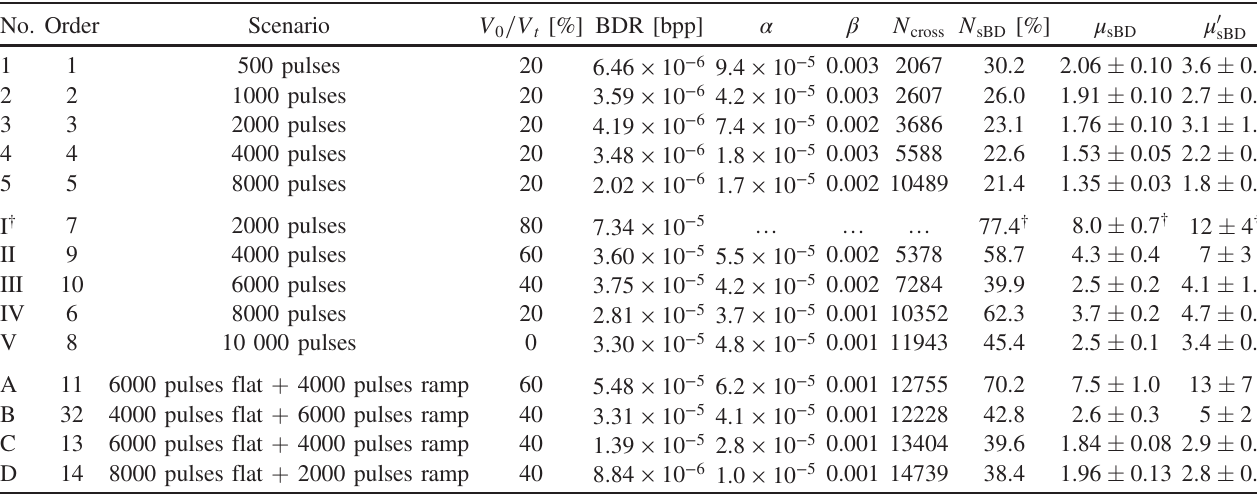
TABLE II. Key figures for the BD experiments with different ramping scenarios. The first column denotes the measurement id and the second one shows the order the measurements were performed in. Values of breakdown rate (BDR), two-exponential PDF fit parameters ( α and β ), cross-point of the two exponentials ( N ), percentage of sBDs ( N ), the average number of BDs between two pBDs cross sBD (including the previous pBD) ( μ ), and the fraction of the number of sBDs to pBDs for those series with at least one sBD ( μ 0 ) for sBD sBD each scenario are listed in the table. The two-exponential fit could not be performed for scenario I, so the values denoted with † are not fully comparable to the other